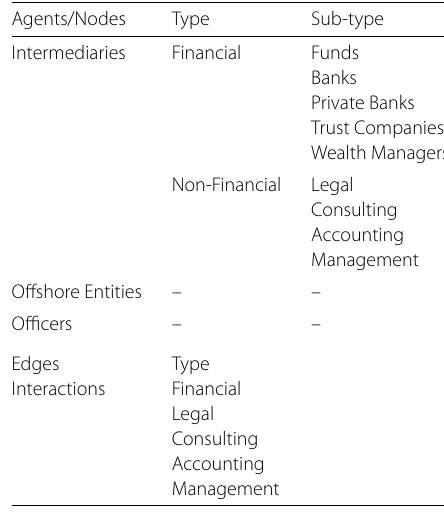
Table 1 Type of Agents and